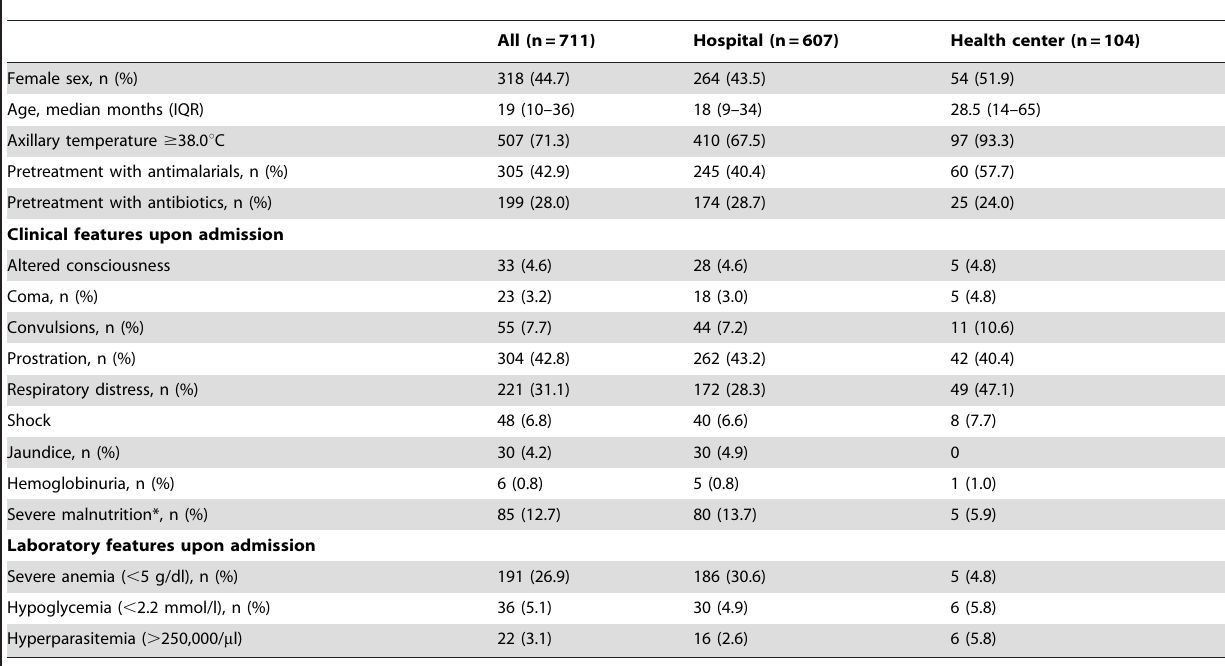
Table 1. Demographic, clinical and laboratory characteristics upon admission.